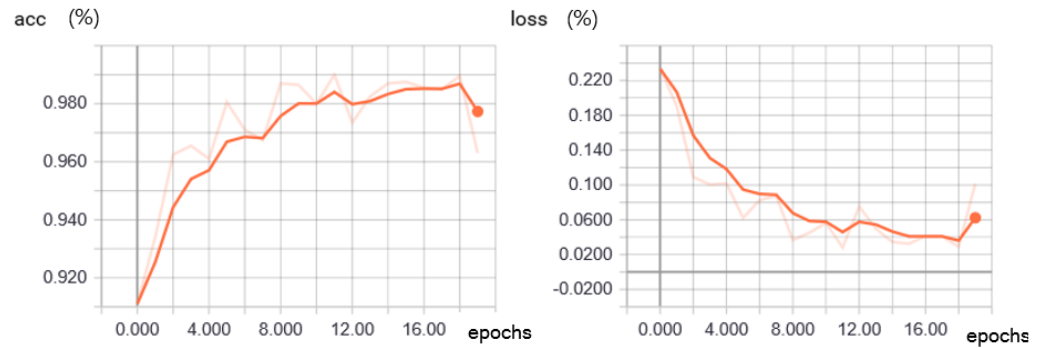
Figure 5. Training accuracy ( left ) and training loss ( right ) of the frost